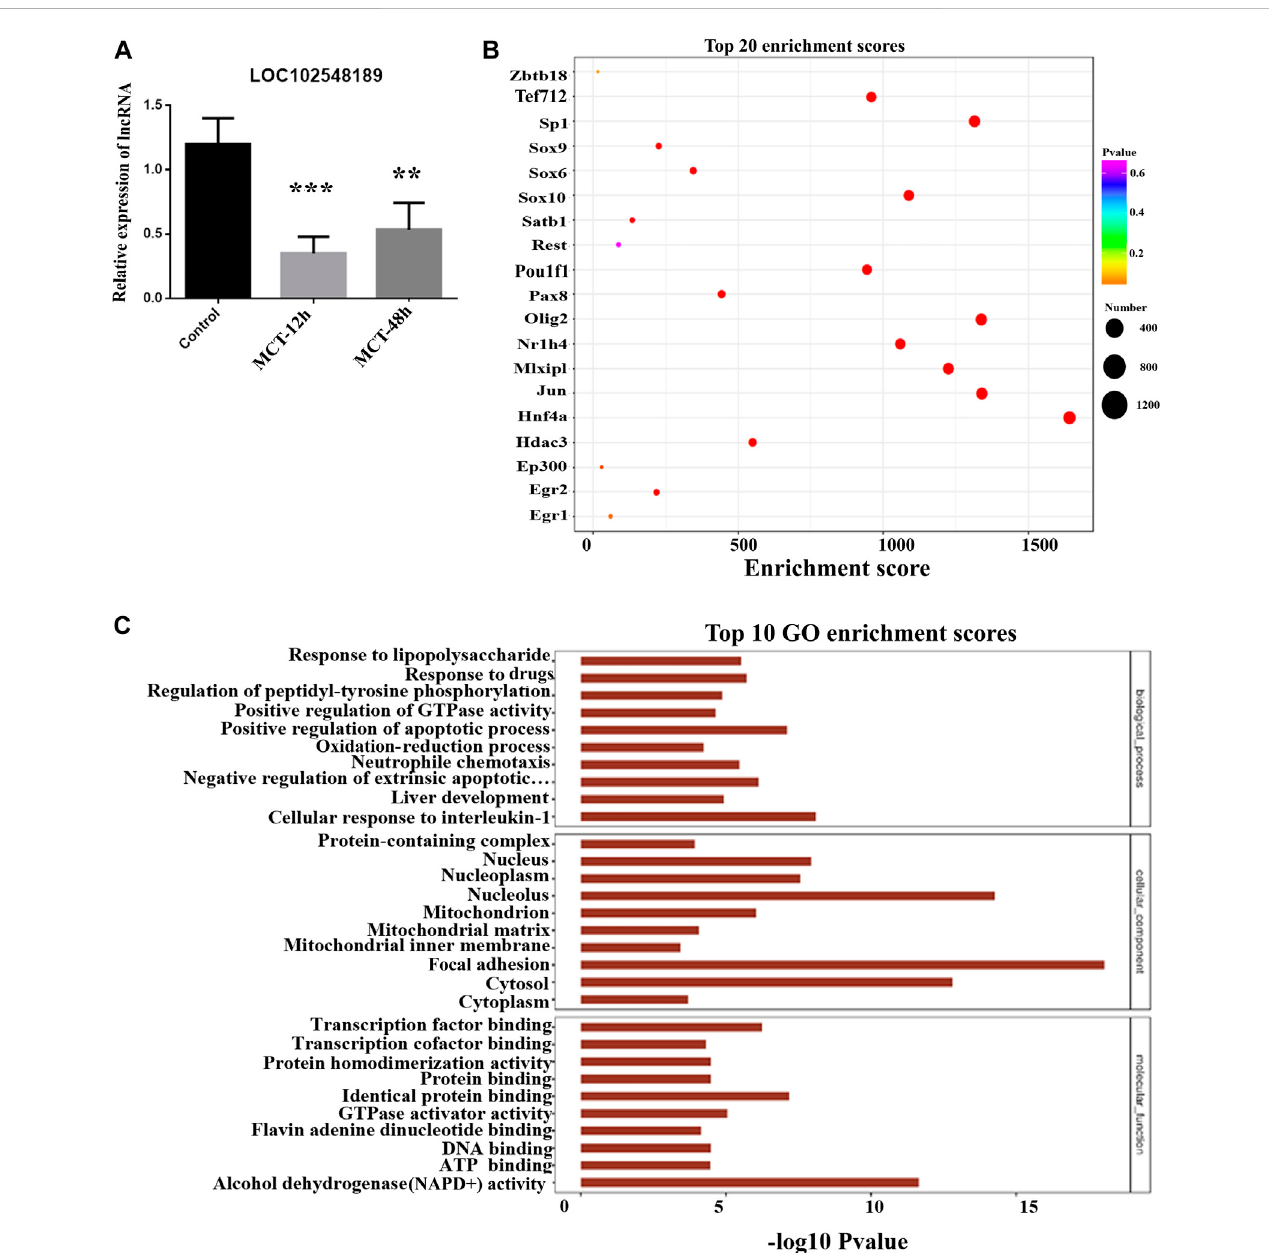
FIGURE 9 Analysis of LOC102548189 functions in MCT-treated rats. (A) Relative expression of LOC102548189 in control and MCT-treated liver tissues (after 12 h and 48 h). Data are presented in the form mean ± SD. n = 6 rats per time point. (B) Bubble chart of the top 20 enriched transcription factors associated with LOC102548189. (C) Top 10 GO enrichment scores for LOC102548189. (D) Top 10 KEGG enrichment results for differentially expressed genes co-expressed with LOC102548189. As the p -value corresponding to enrichment decreases, the signi fi cance level of the enrichment increases. * p ≤ 0.05; ** p ≤ 0.01; *** p ≤ 0.001 in comparisons of the MCT-treated group against the control group. Colors differentiate BPs, CCs, and MFs. BP, biological process; CC, cellular component; MF, molecular